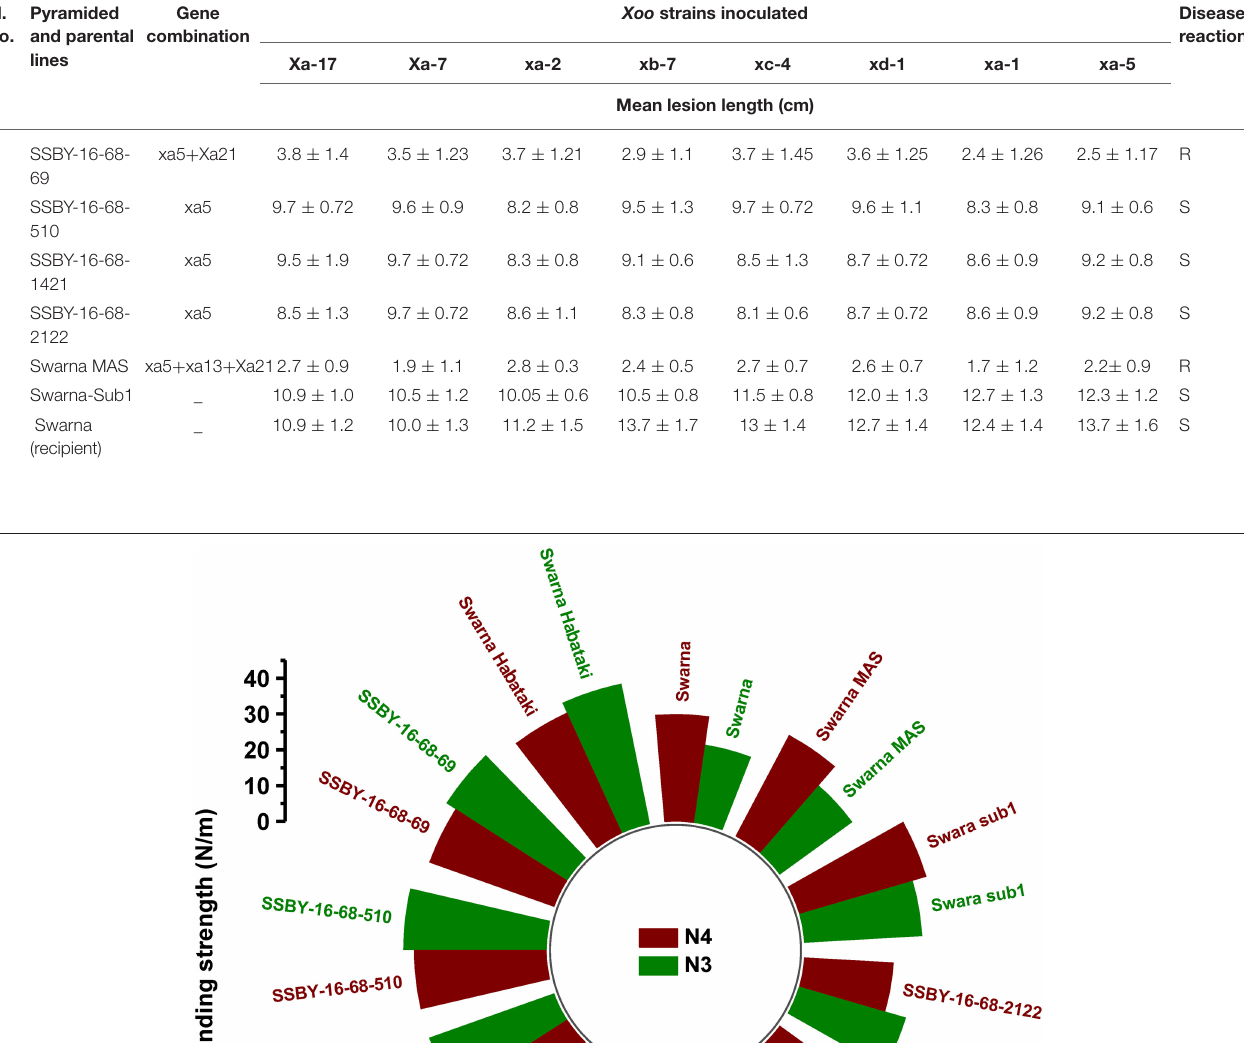
TABLE 2 | Bacterial blight (BB) disease score and reaction of pyramided and parental lines against different Xoo inoculated strains. Sl. Pyramided Gene No. and parental combination lines